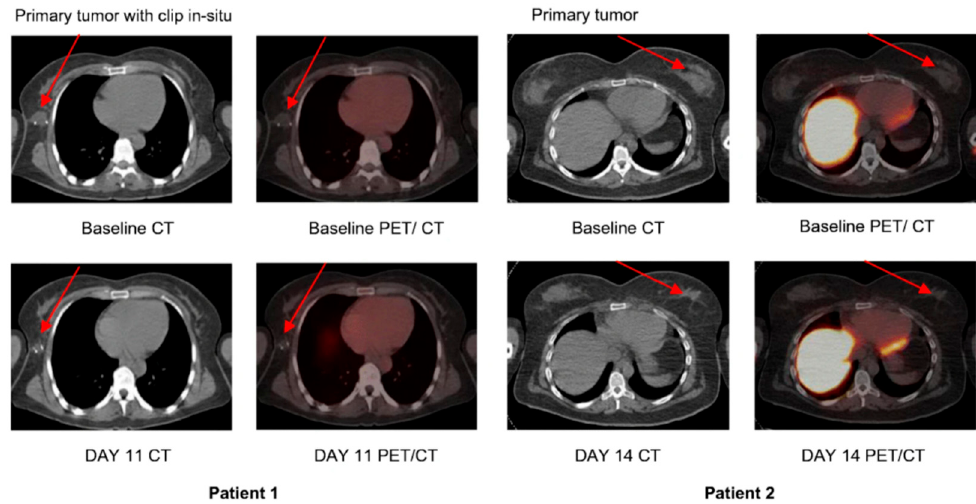
Figure 5. [ 18 F]ICMT-11 uptake in primary breast tumors. Axial CT and fused [ 18 F]ICMT-11 PET/CT images of primary breast tumors in two patients, 1 and 2, at baseline (pre-) and post-chemotherapy. Low-level uptake is noted. Reprinted with permission from ref. [35]. Copyright 2018 Springer Nature.